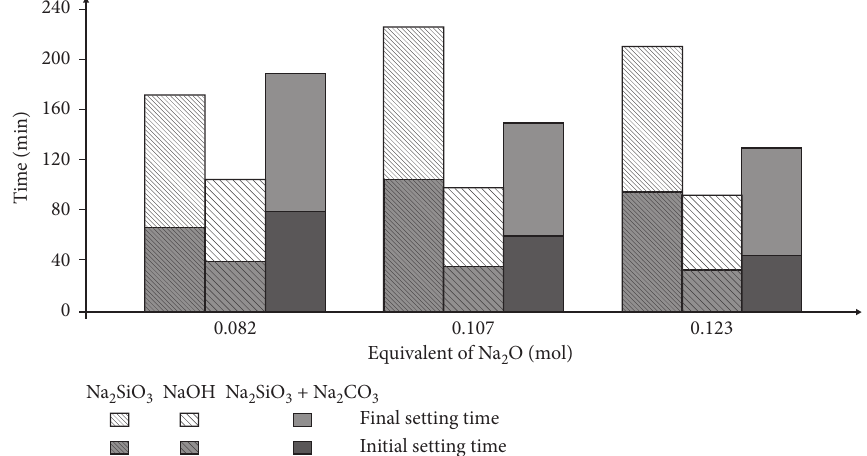
Figure 4: Initial and final setting times for nickel slags activated by different alkali activators with different